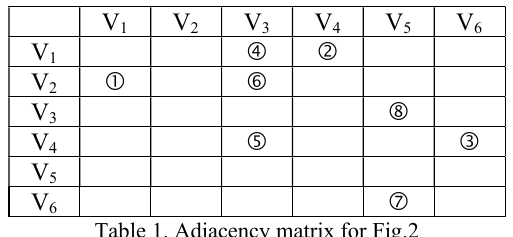
Table 1. Adjacency matrix for Fig.2